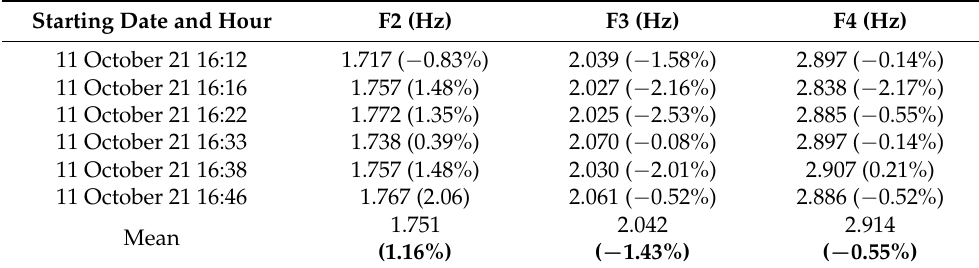
Table 6. Estimation of the natural frequencies at section 2 (new bridge) using App4SHM and comparison with the means of the reference system (GeoSIG) from Table 5 (in